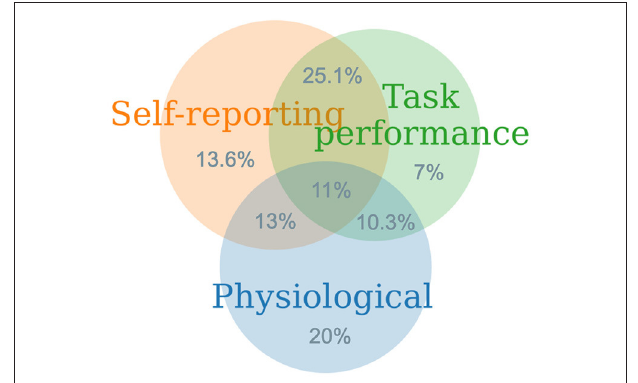
FIGURE 10 | Distribution of the classes of mental workload measures and their joint